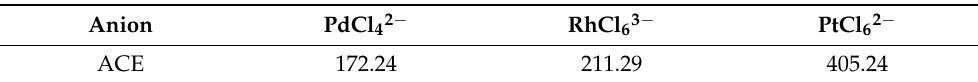
Table 6. The average coordination energy (in kcal/mol) of metal cation with chloridion in